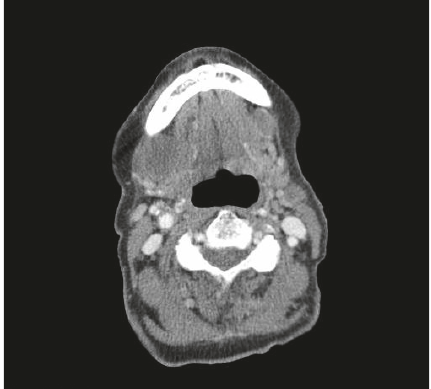
Figure 5: A 2.8 cm focal lesion was identified on the anterior aspect of the right submandibular gland representing an enlarged lymph node. A smaller, 1.6 cm enlarged lymph node was also present on the left